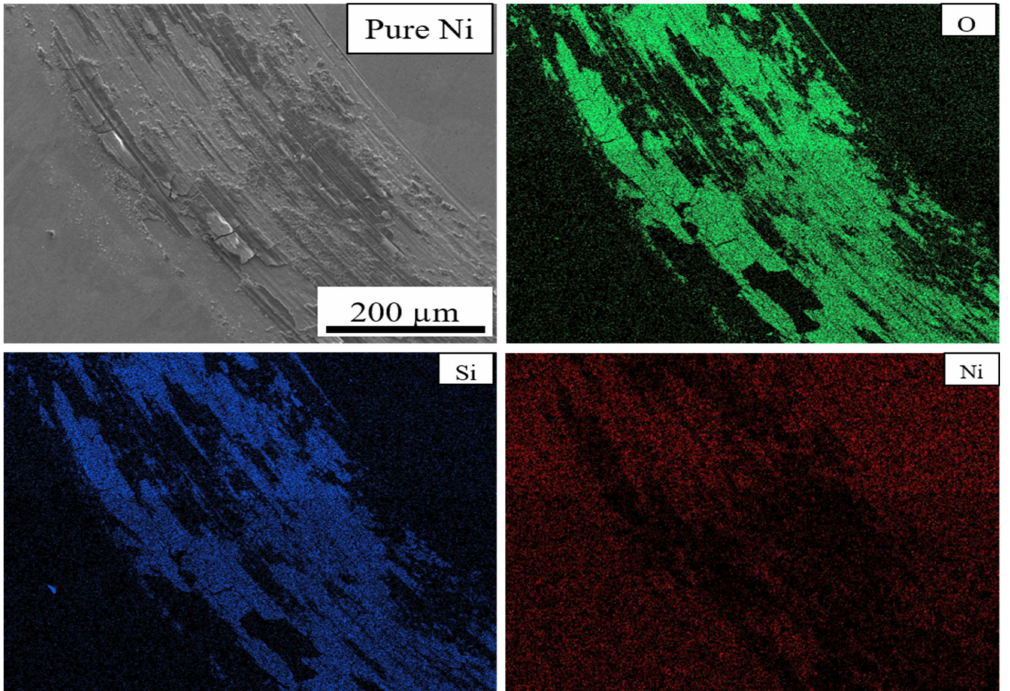
Figure 9. Wear Track EDS Map of Pure